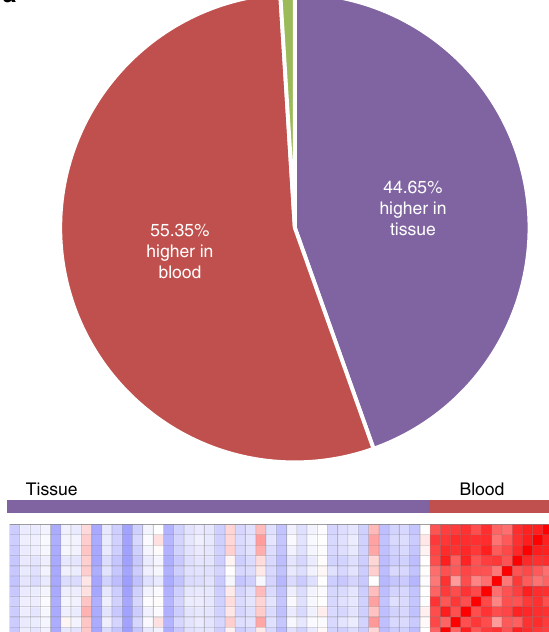
pursued for the treatment of UC 41 . In summary, we identi fi ed immune phenotypes relevant for disease group strati fi cation.